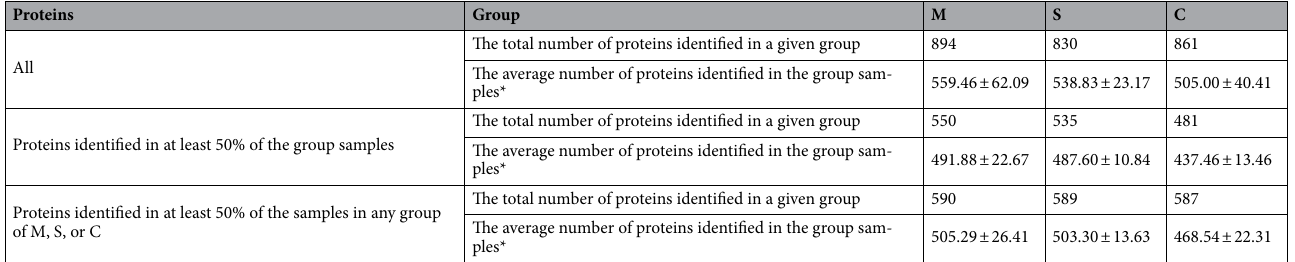
Table 1. Numbers of proteins identified in individual groups. M—patients with acute poisoning, S—long- term surviving patients, C—control group. *The deviation represents one standard